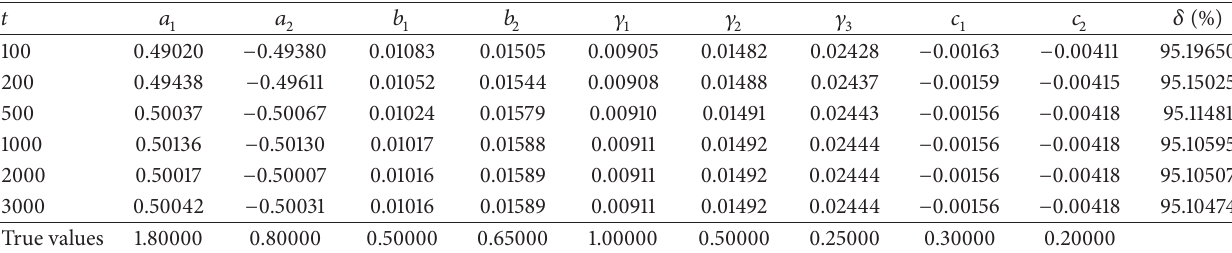
Table 1: The SG parameter estimates and errors.